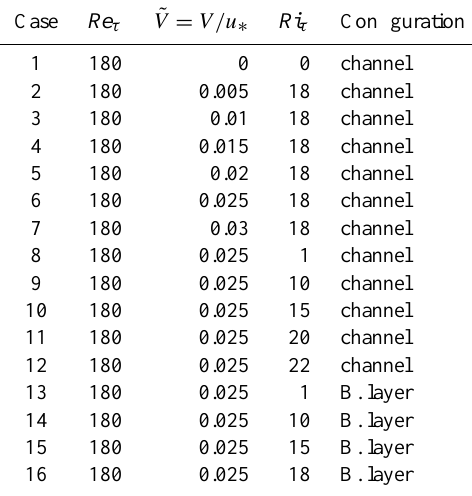
Table 1. The table lists all the cases of direct numerical simulations used in the current study. All the simulations have the same Re τ . cases.